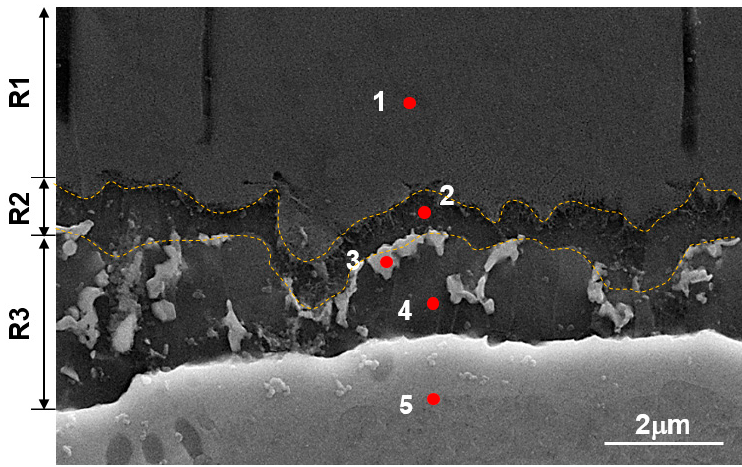
Figure 5. SEM image showing microstructure denoted as rectangle in Figure 1a and EDS analysis results of phases denoted as 1–5.